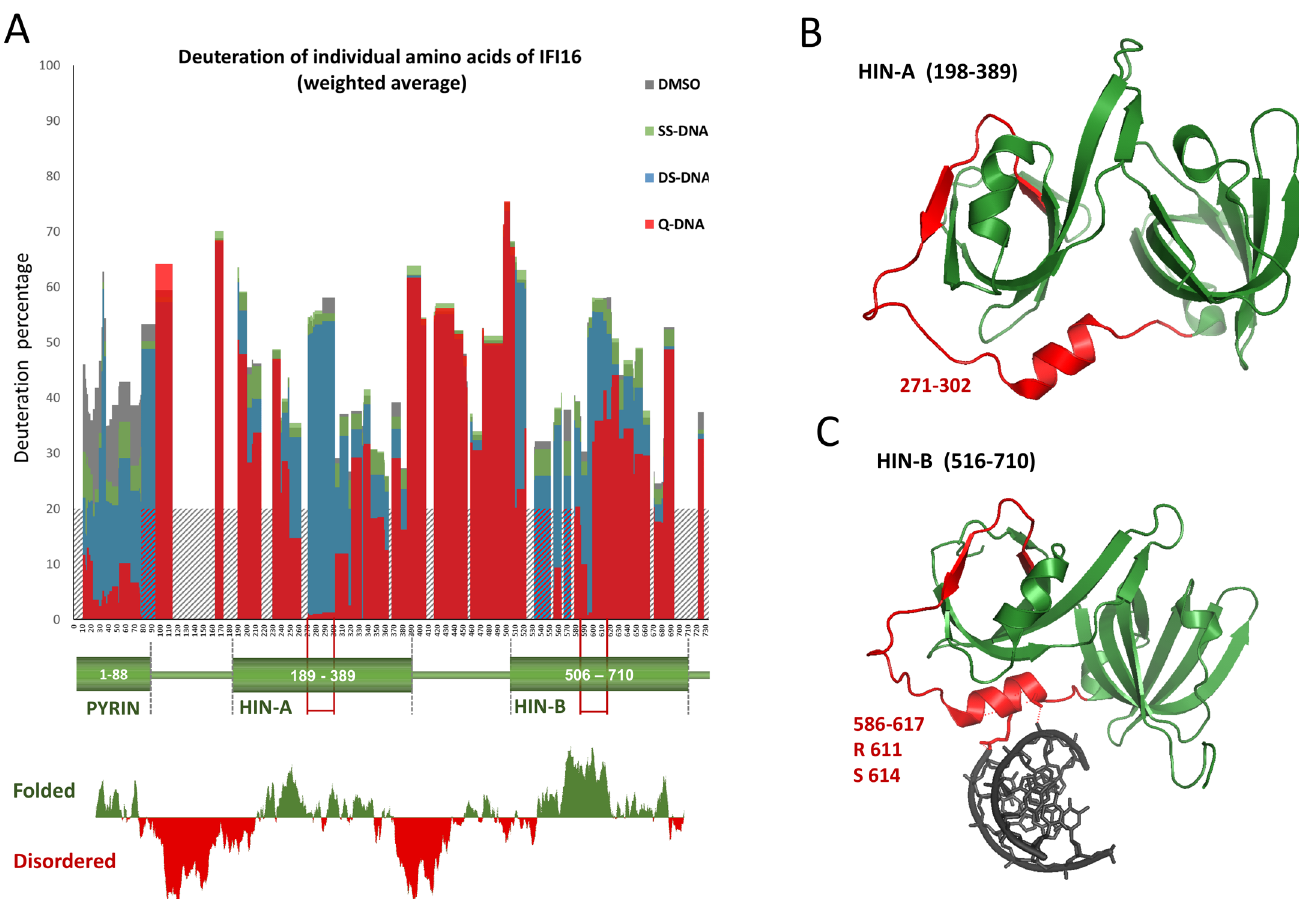
Fig 3. H/D exchange of IFI16 in response to DNA interaction. (A) H/D exchange of IFI16 in response to DNA interaction was analyzed in four reactions: IFI16 protein without DNA as a control, IFI16 with single stranded DNA oligonucleotide (SS DNA), IFI16 with double stranded DNA oligonucleotide (DS NHE III) and IFI16 with DNA forming quadruplex structure (Q NHEIII). H/D exchange was quenched at 900 s after addition of deuterium. The graph shows percentage deuteration of individual amino acids of IFI16 calculated as weighted average of corresponding peptides [53]. Shaded area of the graph shows the areas not covered by peptides. The deuteration spectrum is aligned with the domain structure of IFI16 and with prediction of disordered regions (FoldIndex [54]). (B) Structure of the first HIN-A domain (PDB 2OQ0) corresponding to amino acids 198 – 389 of IFI16 [14]. (C) Complex of the second HIN-B domain with DNA (PDB 3RNU) corresponding to amino acids 516 – 710 of IFI16 [23]. In (B) and (C) the helical linker peptide exhibiting the most significant changes in percentage of deuteration in the presence of quadruplex DNA is highlighted in red.